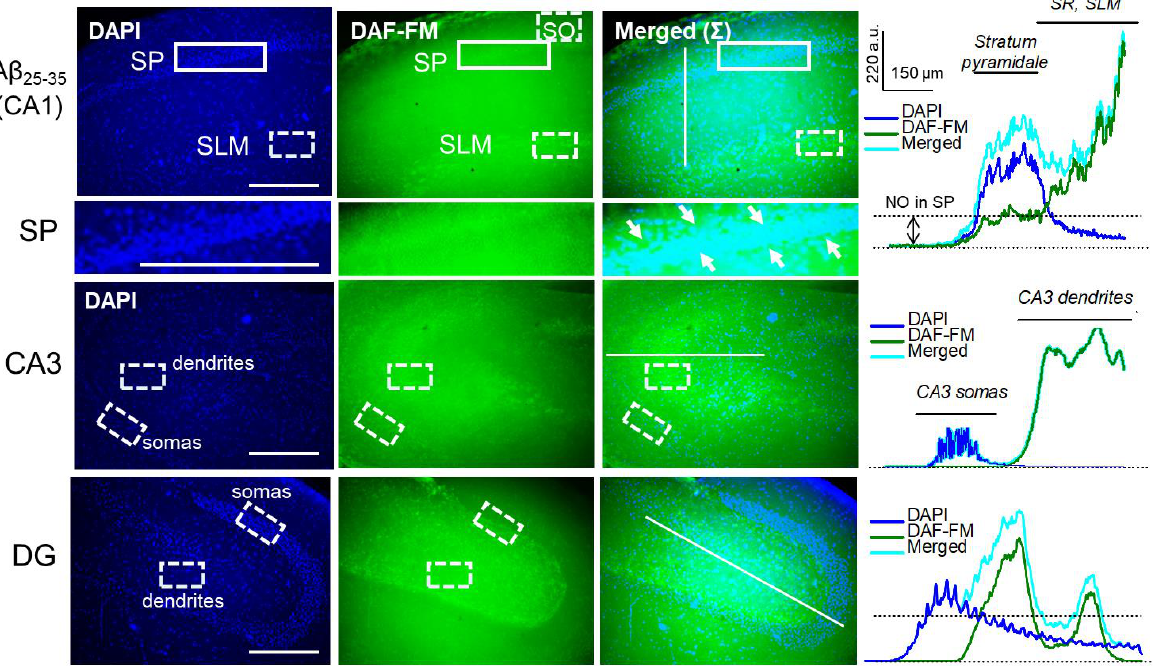
Figure 6. NO staining by DAF-FM dye in the A β 25-35 -treated hippocampal slices reveals a potent NO production in key hippocampal layers, such as CA1, stratum pyramidale (SP, arrows), stratum radiatum (SR), stratum lacunosum-moleculare (SLM), CA3, and dentate gyrus (DG). Blue fluorescence channel indicates staining of cell nuclei by DAPI. Scale bars 300 µ m. Right panels indicate curves for fluorescent channel profiles, corresponding to the lines in merged ( Σ ) channel. SO—stratum